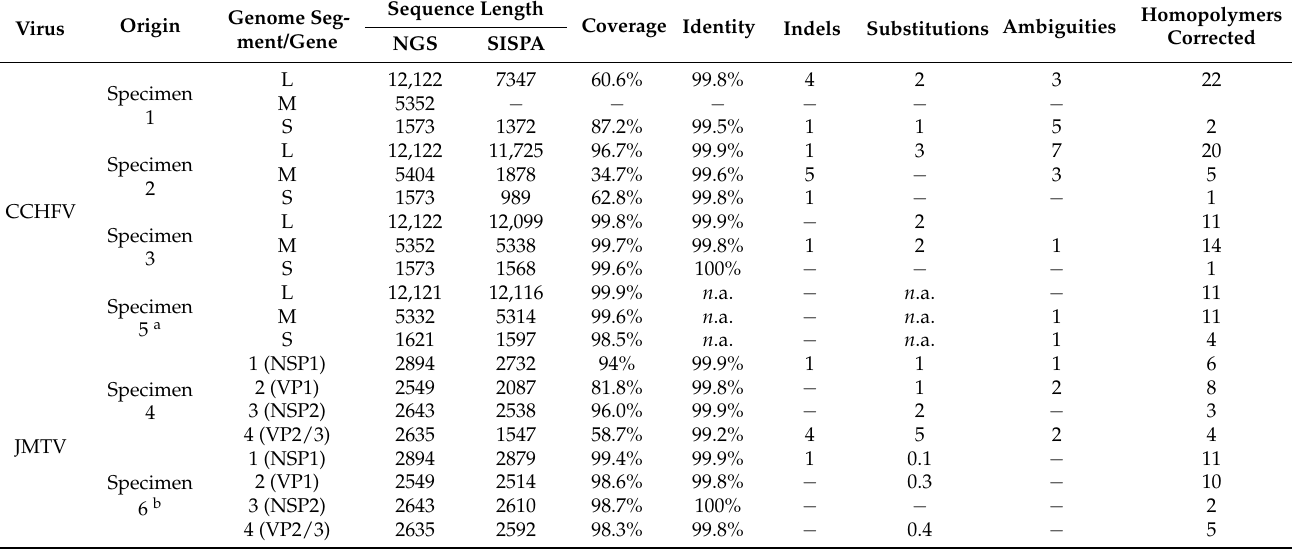
Table 2. Virus and genome-specific comparison of the SISPA sequence